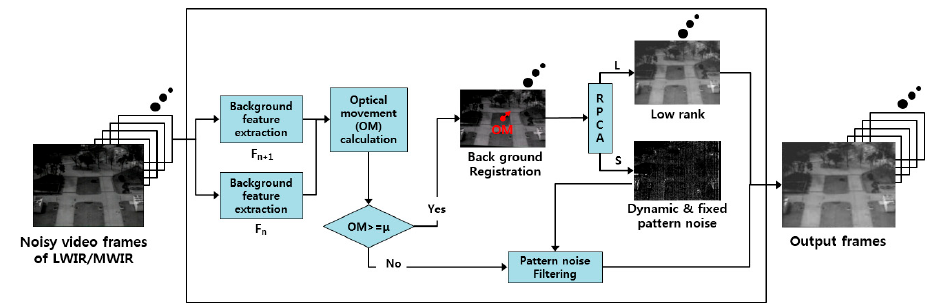
Figure 4. Block diagrams of proposed BRANF algorithm.